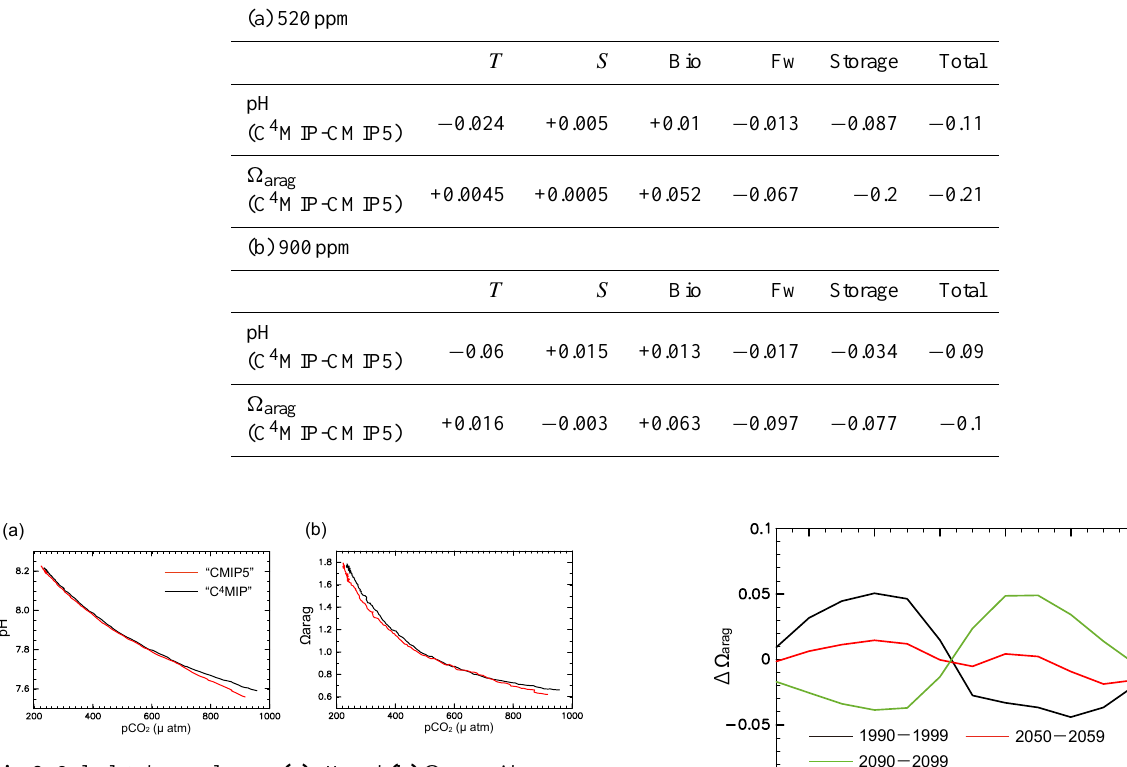
Fig. 8. Calculated annual mean (a) pH and (b) (cid:127) arag with seawa- ter p CO 2 in the Arctic surface waters for “C 4 MIP” (black) and “CMIP5” (red).